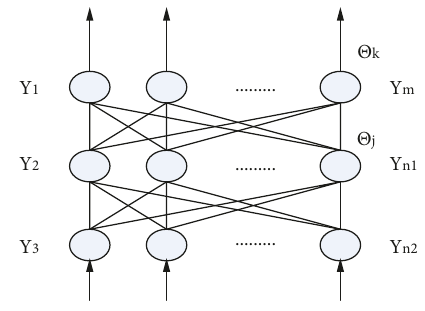
Figure 3: A three-layer feedforward neural network.